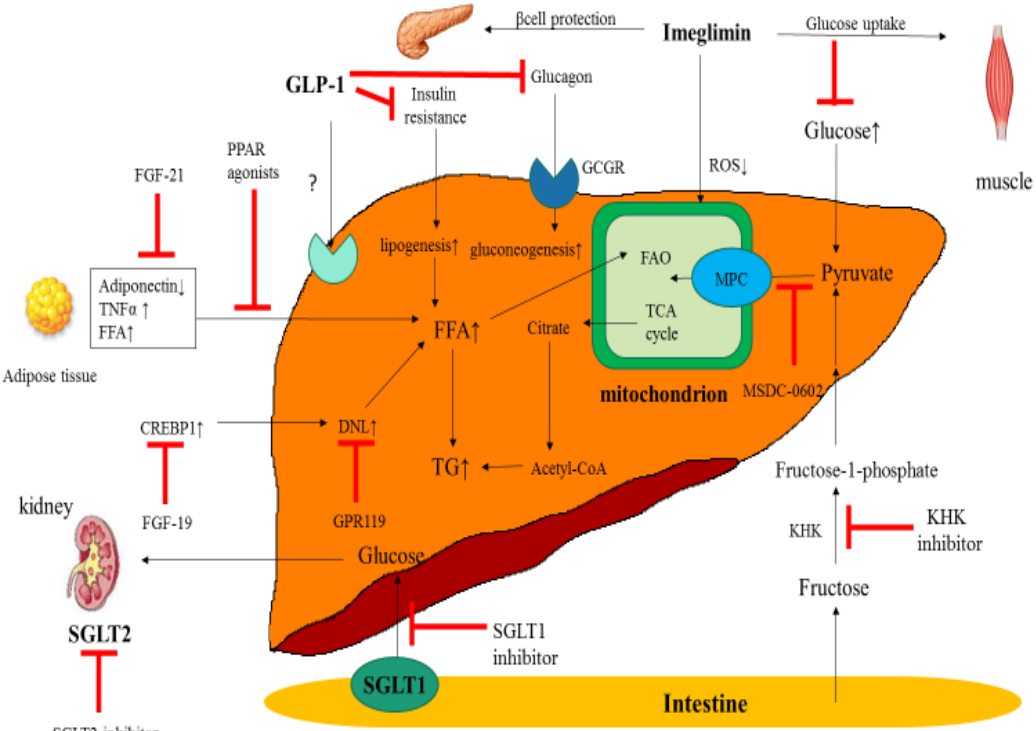
Figure 1. Mechanisms of antidiabetic therapies for nonalcoholic steatohepatitis (NASH). GLP-1: glucagon-like peptide, DNL: de novo lipogenesis, TNFα: tumor necrosis factor α, FFA: free fatty acid, TG: triglyceride, KHK: ketohexokinase, GCGR: glucagon receptor, GPR: G-protein-coupled receptor, MPC: mitochondrial pyruvate carrier, SGLT: sodium-glucose cotransporter, TCA: tricarboxylic acid, ROS: reactive oxygen species, PPAR: peroxisome proliferator-activated receptor, FGF: fibroblast growth factor, CREBP: cAMP-response element-binding protein, FAO: fatty acid oxidation.